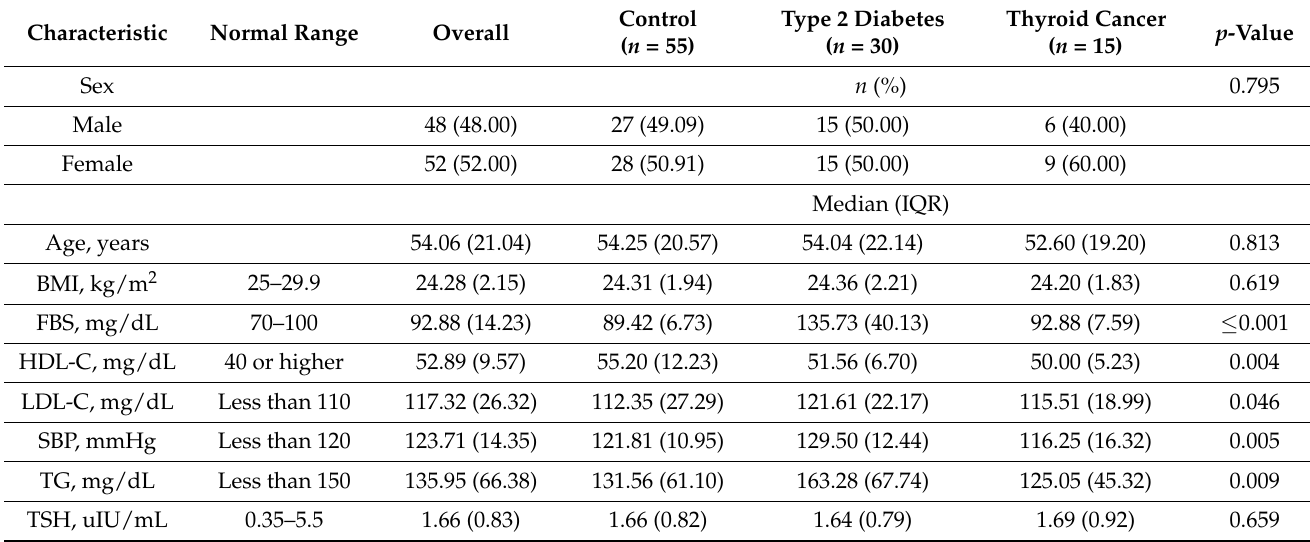
Table 1. Baseline characteristics of 500 individuals who constructed 100 pooled samples in the KCPS-II.